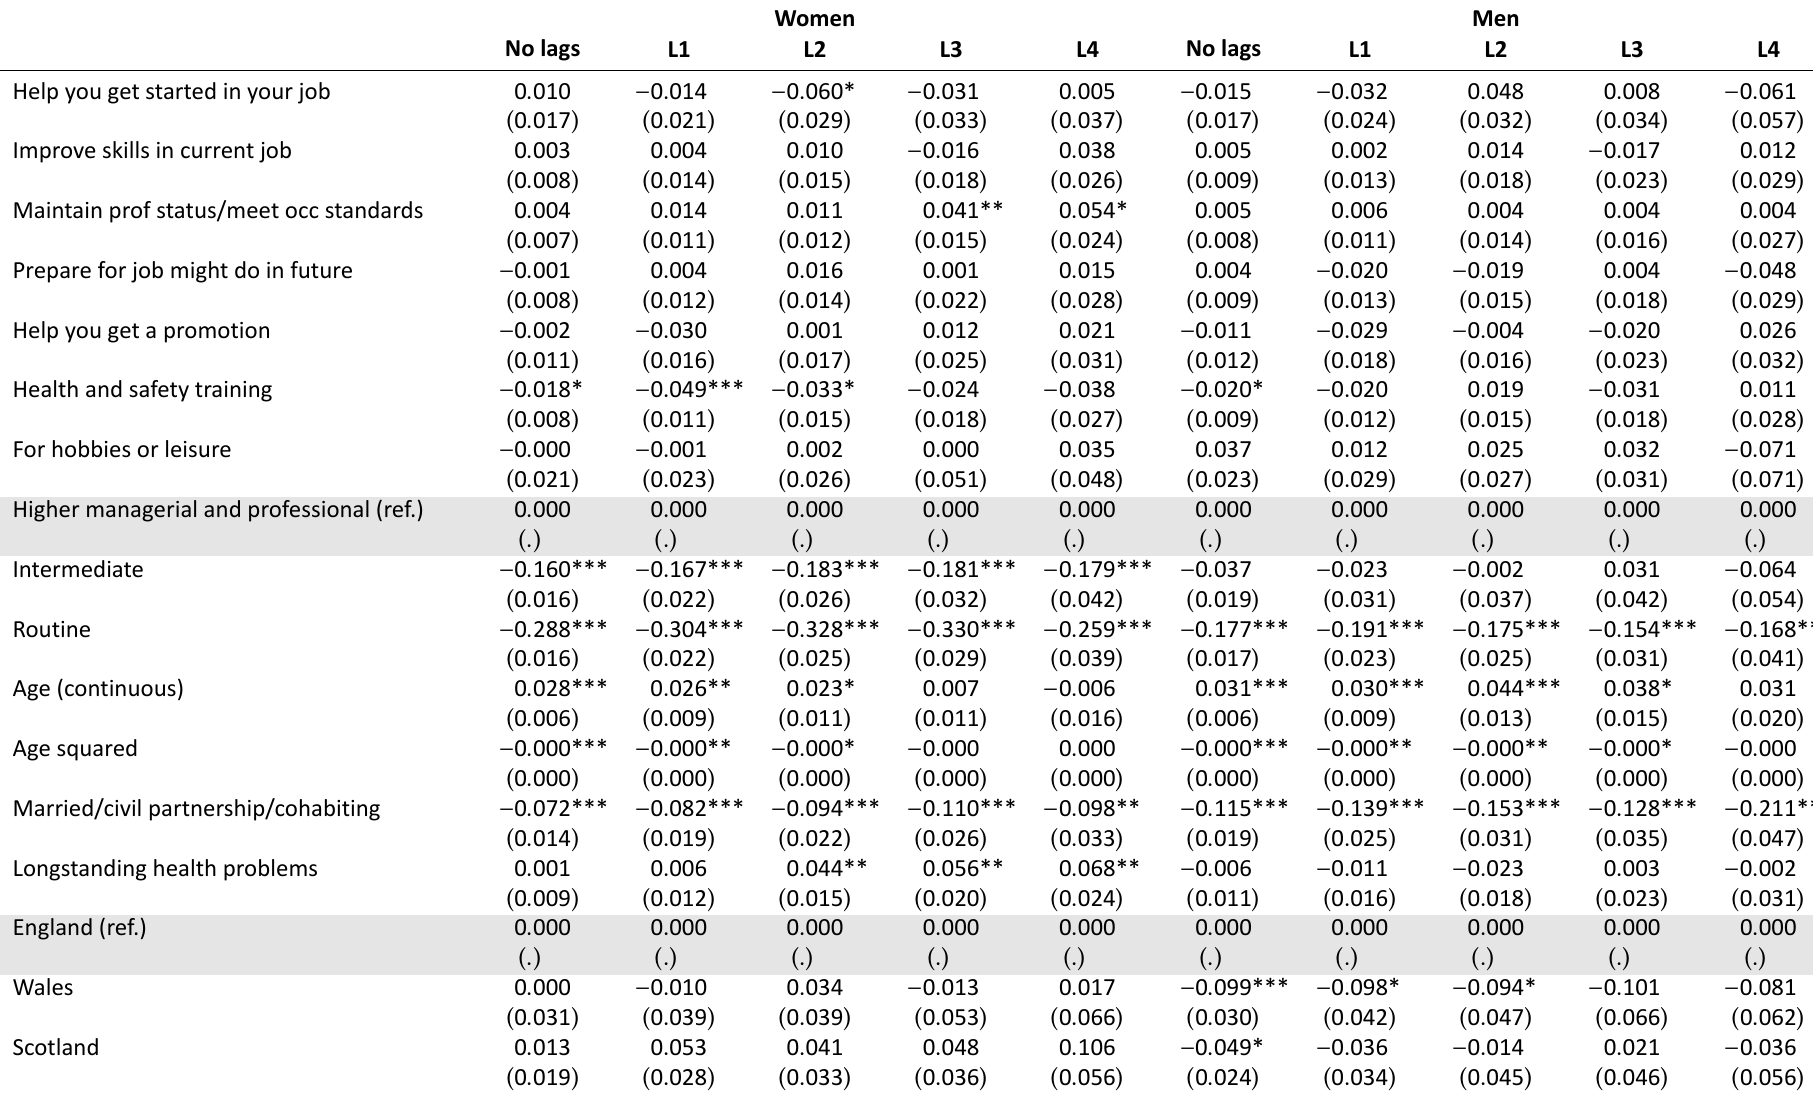
Table A5. Regression results, association between different reasons for participation in training and wages (log of hourly earnings), random effects.